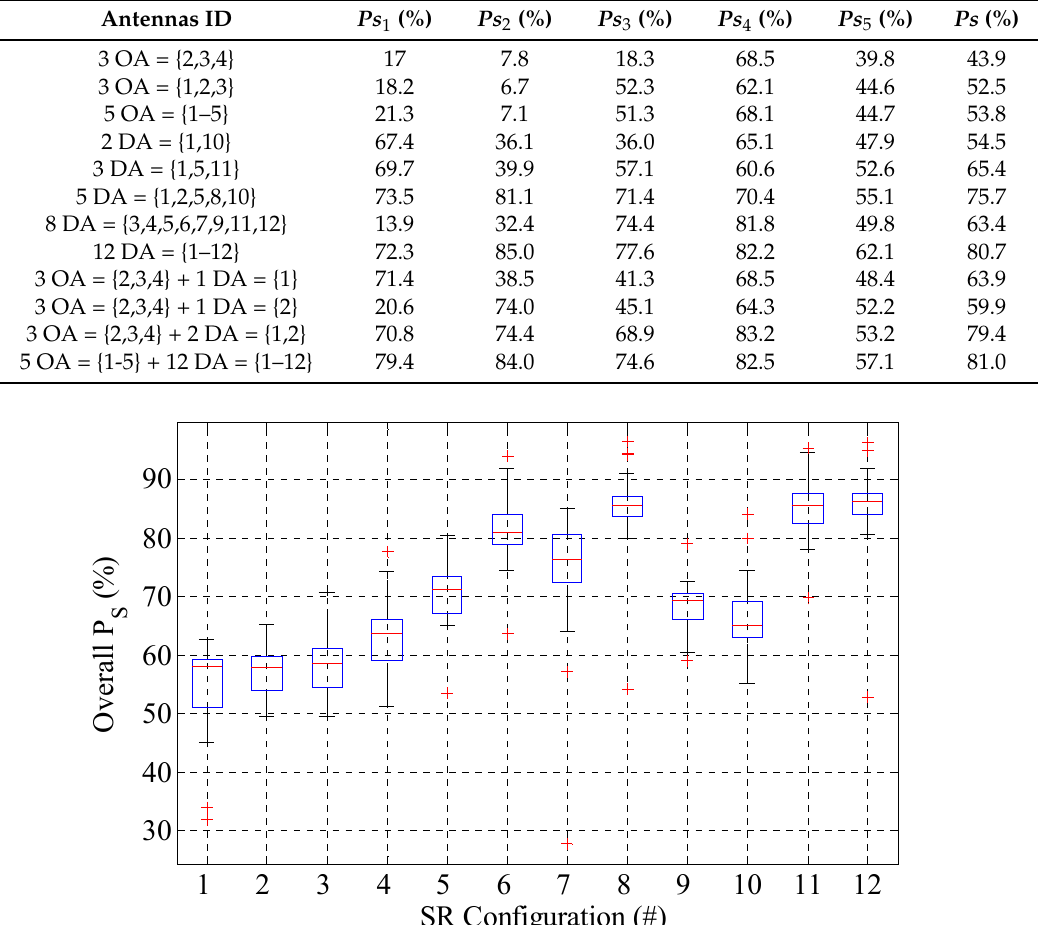
Figure 13. Box-and-whisker plot for the P S resulting from 27 test pathways for the configurations presented in Table 2.